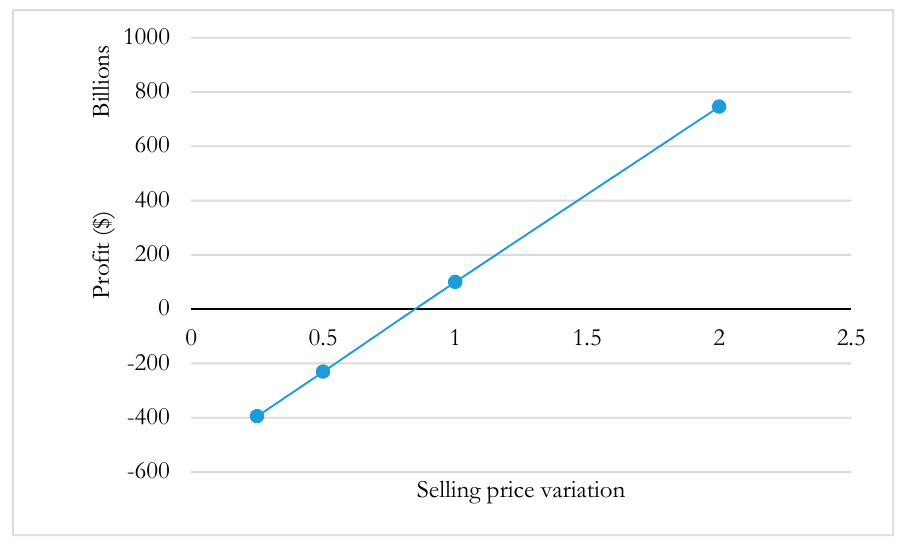
Figure 8. Profatibility changes with variation in demand.